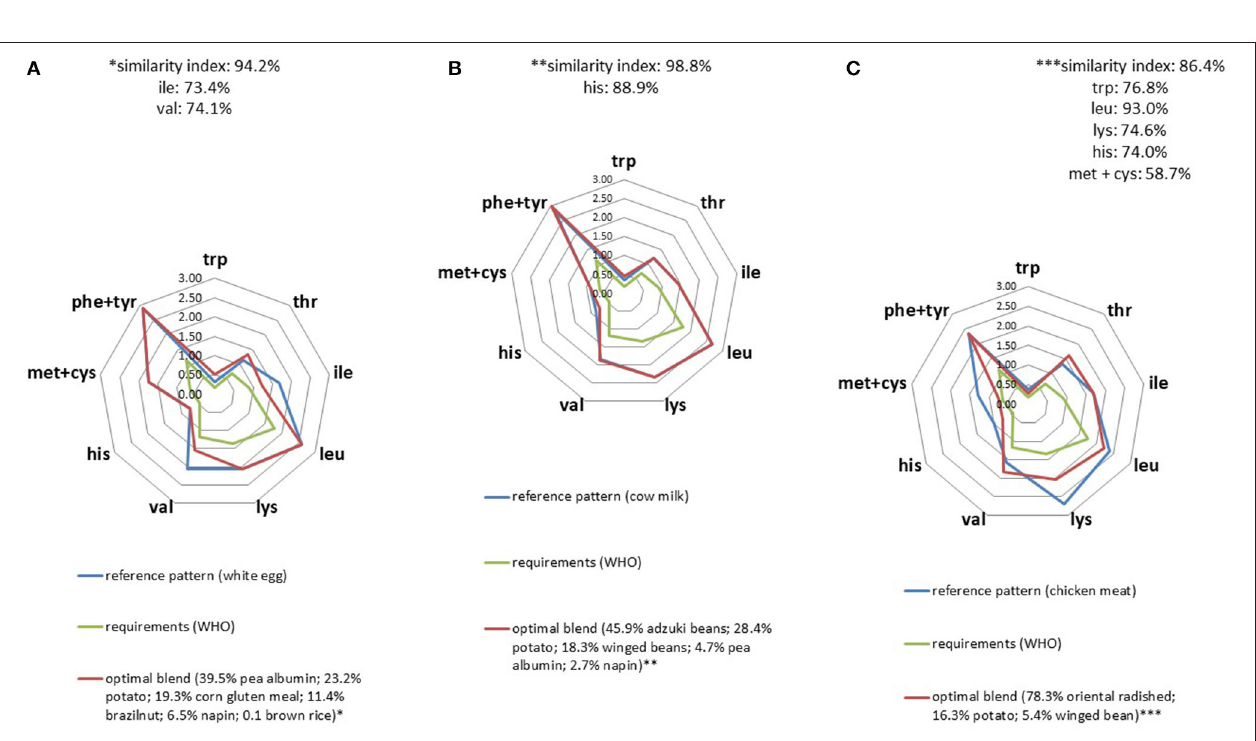
FIGURE 2 | IAA profiles (g/30g) of optimal plant protein blends that best replicated the IAA profiles of egg white (A) , cow milk (B) , and chicken meat (C) .